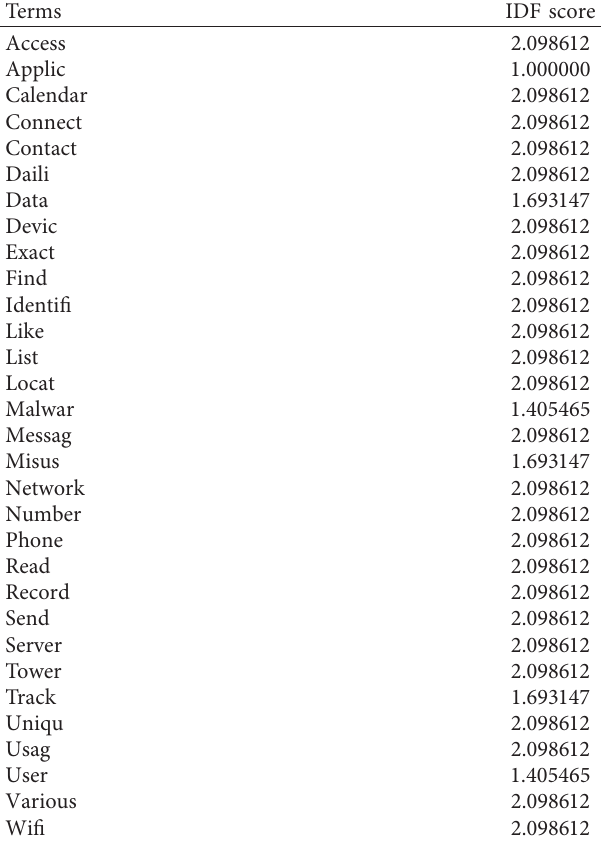
Table 5: Inverse document frequency score for each